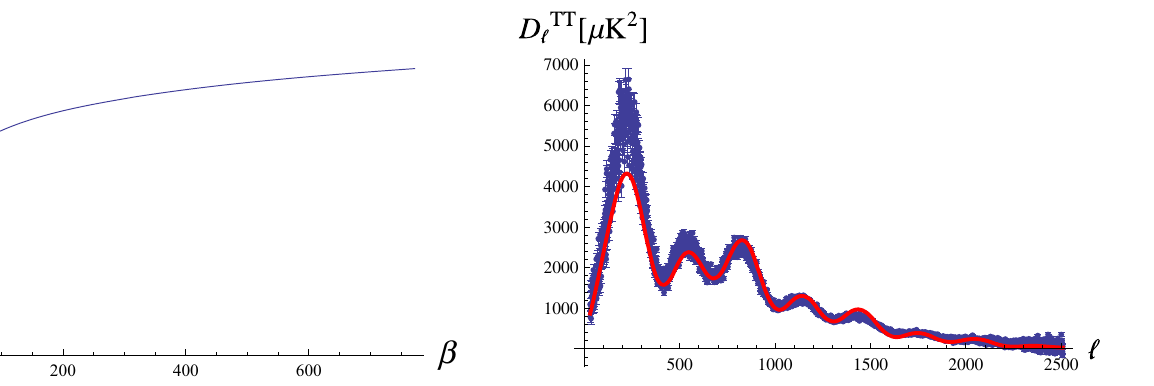
Fig. 7 Diagram of the temperature power spectrum of CMB for the best fit values (red line). The error bars from the Planck data are pre- sented by the color blue Table 1 The best fit and errors for the estimated model with α from the , 0 . 036 100 km ) interval(00.0,0.033), Γ 0 / ¯ h fromtheinterval ( 0 . 00 100 km s × Mpc s × Mpc and (cid:16)/ 3 H 2 from the interval (0.00, 0.0175). We assumed that Ω b , 0 = 0 0 . 048468, H 0 = 67 . 74 km and Ω m , 0 = 0 . 3089. In the table, the s × Mpc values of Γ 0 / ¯ h are expressed in 100 km . Because α = 1 , the best fit s × Mpc 1 + β value of β parameter is equal to 799 Parameter Best fit